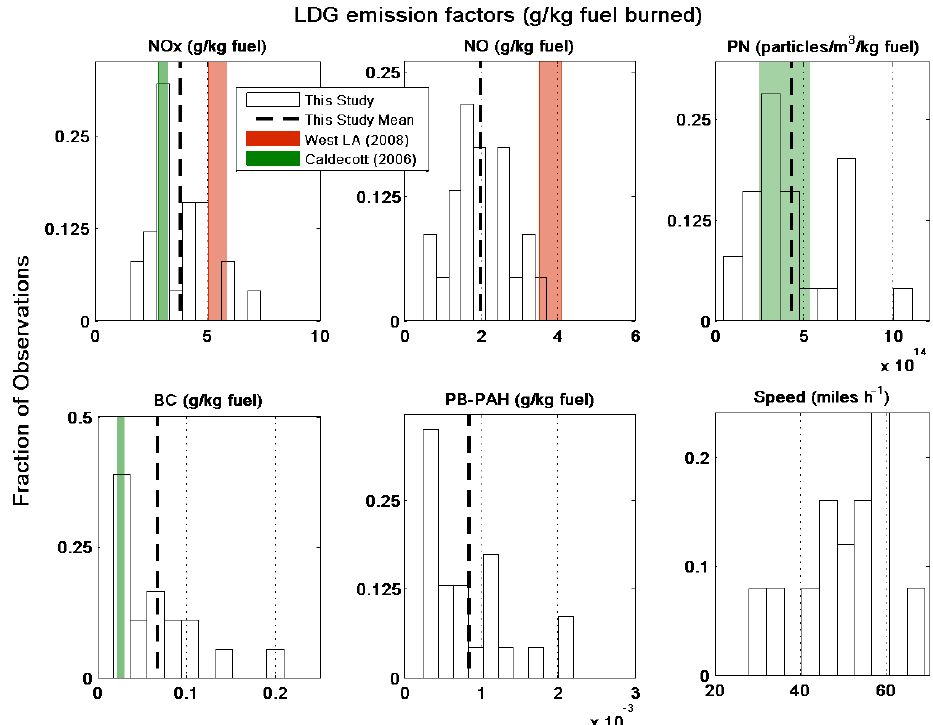
Fig. 1. LDG emission factors (measured on CA SR-110, total number of observations = 25). Caldecott (2006) refers to Ban-Weiss et al. (2008, 2010) results, and West LA (2008) refers to Bishop et al. (2010) results. The colored bars represent the reported one standard deviation range. Also note the exponents on the x-axis for PN and PB-PAH